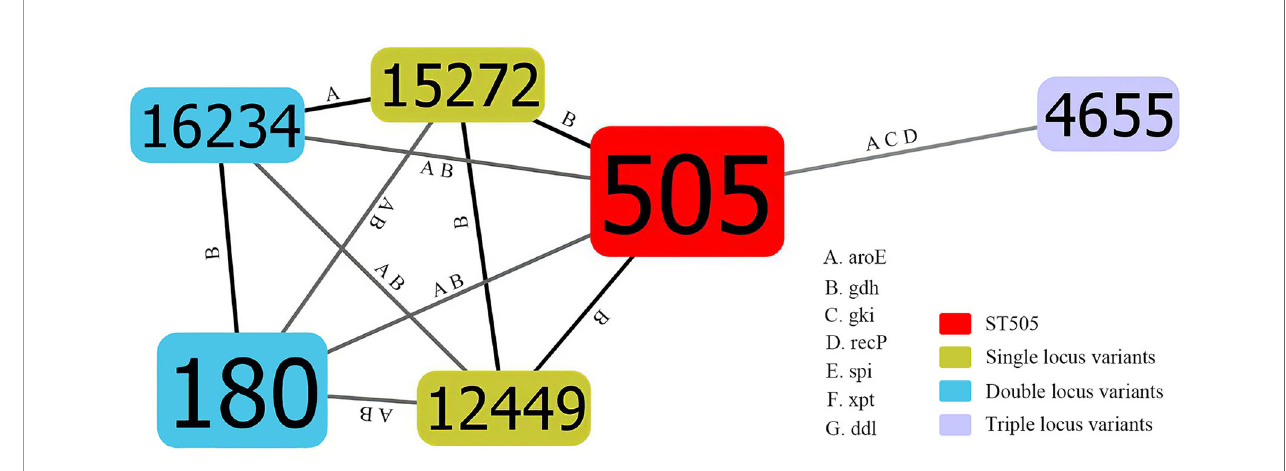
FIGURE 1 | Population snapshot of mucoid serotype 3 S. pneumoniae . The STs were displayed as a goeBURST nLVs graph based on the allelic pro fi les. Each number represents one ST, and the area of each circle indicates the prevalence of ST in the MLST data of this study. All 6 STs were shown here and the different alleles between STs were presented. The letter A, B, C, D, E, F and G indicates aroE , gdh , gki , recP , spi , xpt and ddl , respectively. SLVs, DLVs and TLVs of ST505 were shown by different colors. MLST, Multilocus sequence typing; ST, Sequence type; SLVs, Single locus variants; DLVs, Double locus variants; TLVs, Triple locus